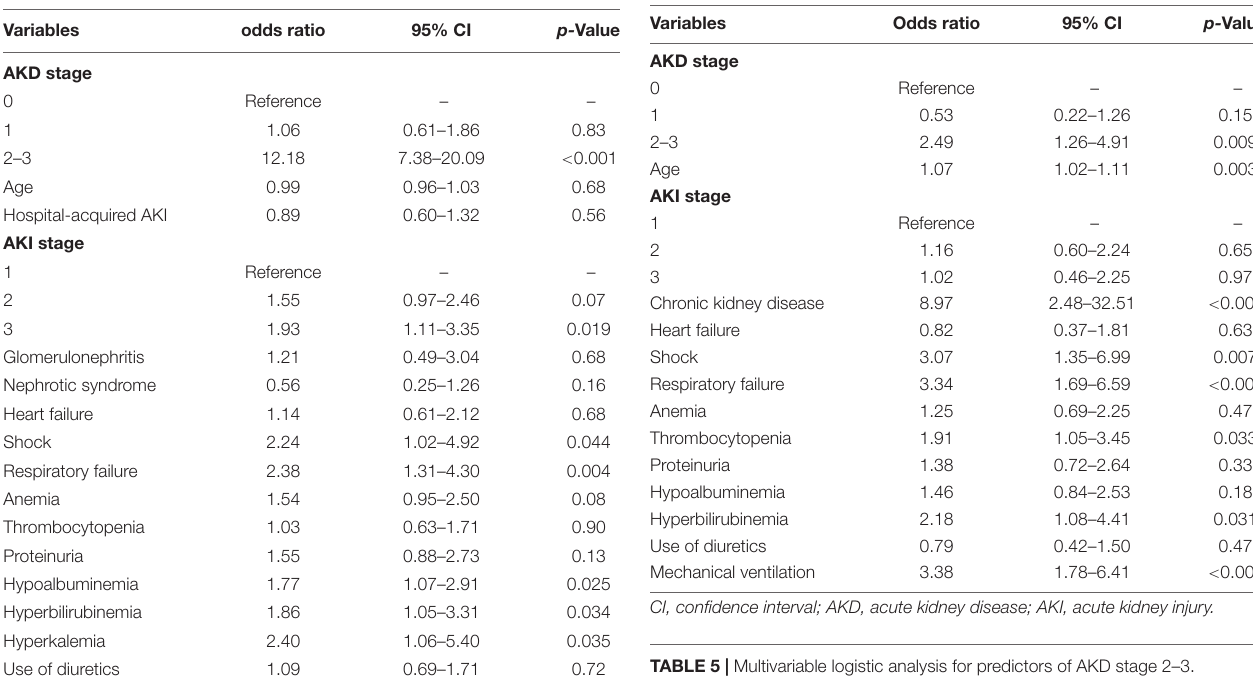
TABLE 4 | Multivariable logistic analysis for predictors of 90-day adverse outcomes.